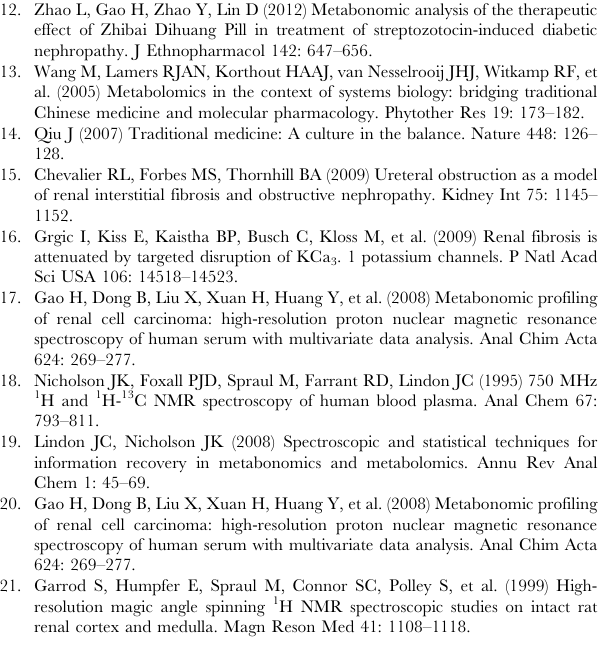
Table S1 Serum clinical chemistry parameters of different dosages of CAO on RIF rats for 7